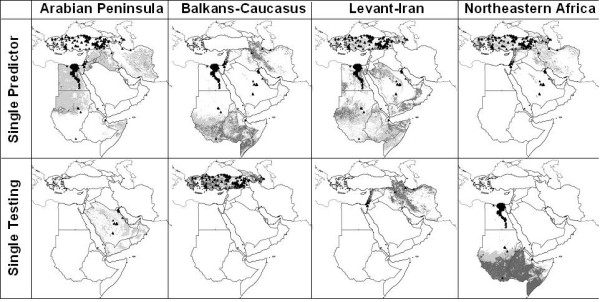
Spatially stratified tests of ENM predictions of HP-H5N1 distributions in the Middle East and northeastern Africa. Here, occurrences from each subregion predict distributions of cases in the rest of the region, and vice versa. Model predictions are shown as ramps of model agreement in predictions: light grey = 5–9 models predict potential presence, dark grey = all models agree in predicting potential presence. Only independent test points are plotted on maps. The dense cluster of testing points along the lower Nile River in northeastern Africa as testing region analyses covers an area predicted to be suitable.